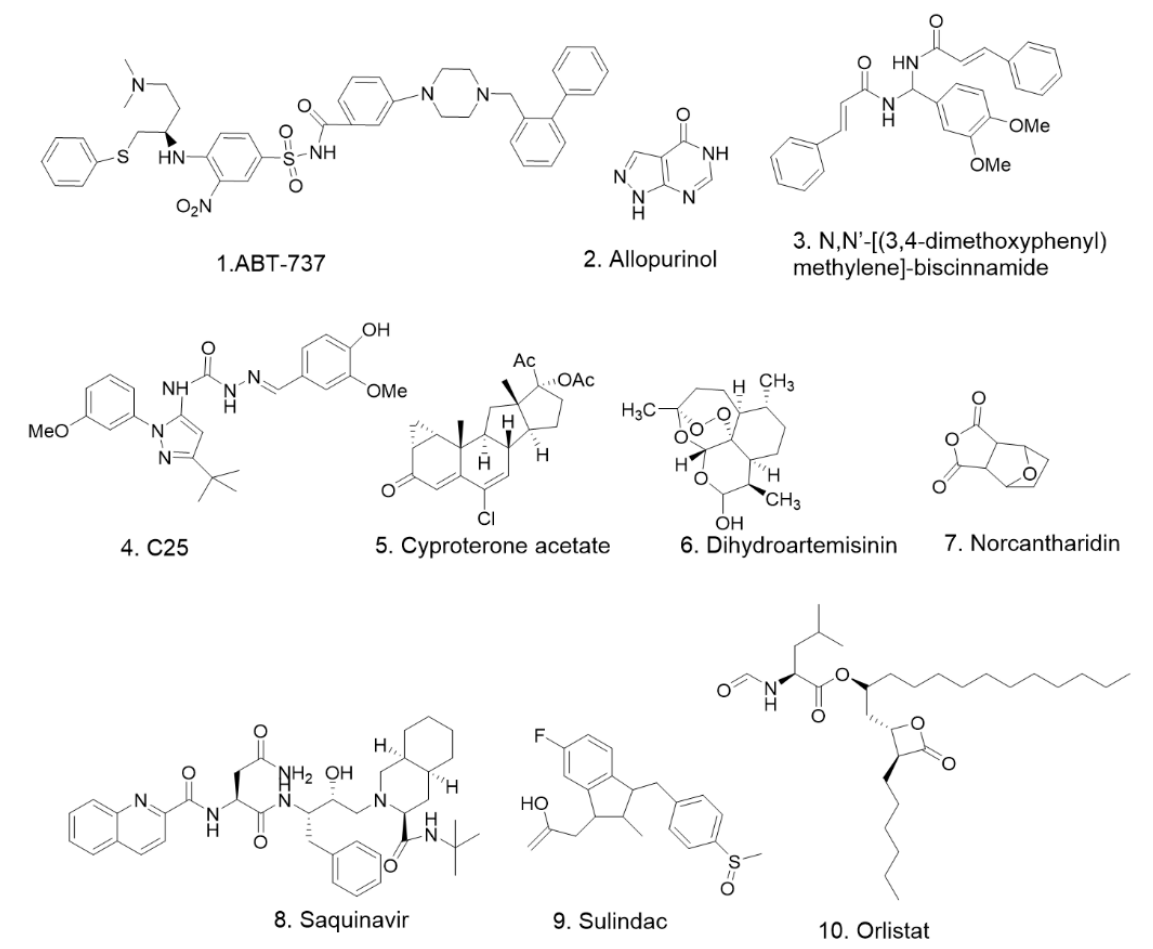
Figure 3. The chemical structures of compounds in Table 3.